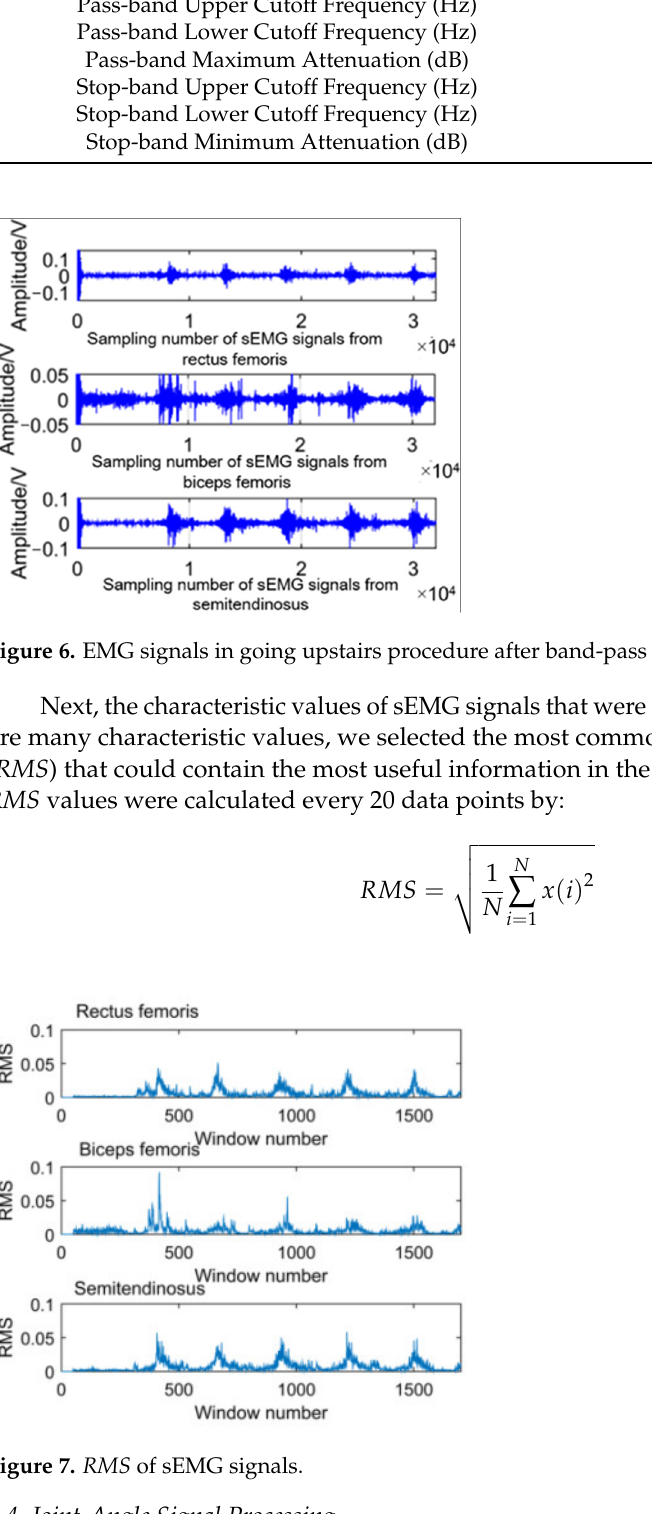
Figure 7. RMS of sEMG signals.